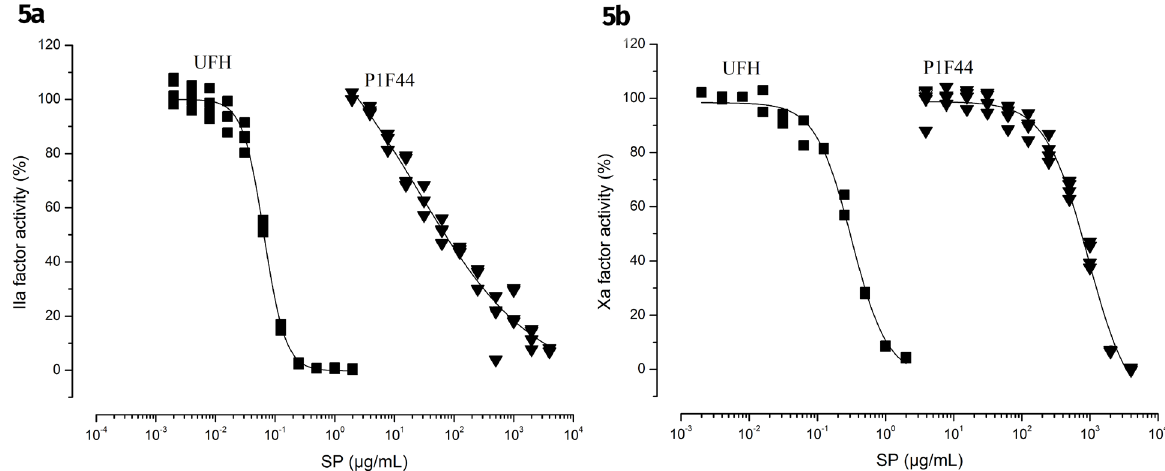
Figure 5. Inhibition of coagulation factors IIa (a) and Xa (b) by the P1F44 fraction obtained from H. opuntia in the presence of antithrombin. UFH – Unfractionated Heparin. Table II. Inhibitory concentration of the P1F44 fraction obtained from H. opuntia compared to other polysaccharides of marine origin and to the heparin